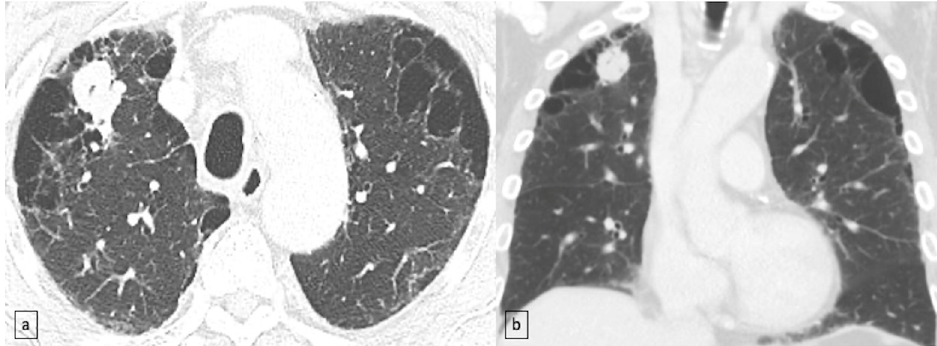
Fig 3. Squamous cell carcinoma and paraseptal emphysema. Axial (a) and coronal (b) CT images demonstrate right upper lobe squamous cell carcinoma and severe upper lobe paraseptal emphysema.